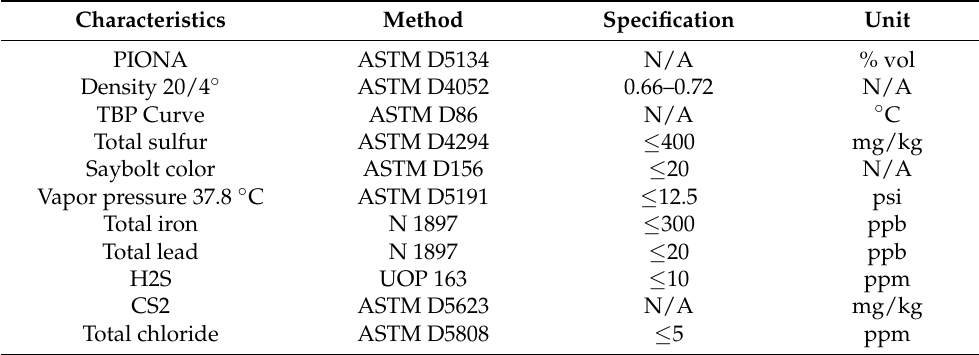
Table 4. Parameters usually evaluated for naphtha characterization